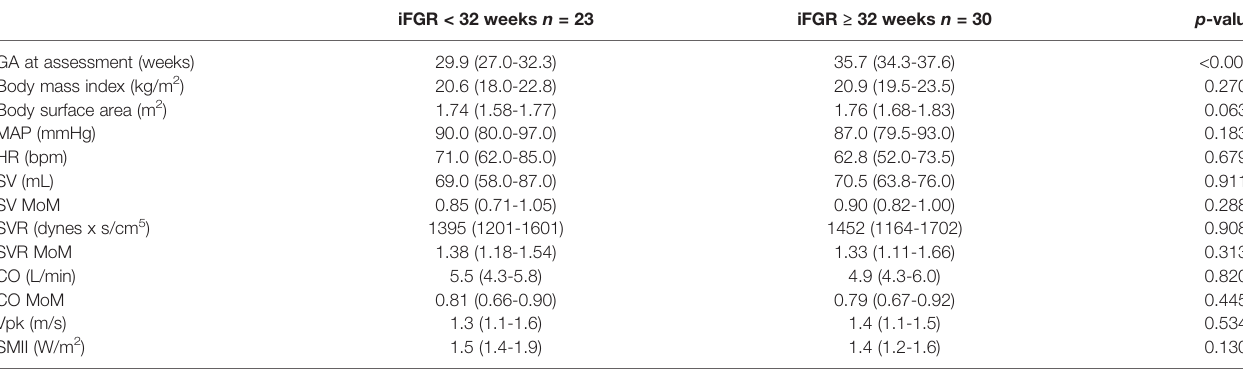
iFGR < 32 weeks n = 23